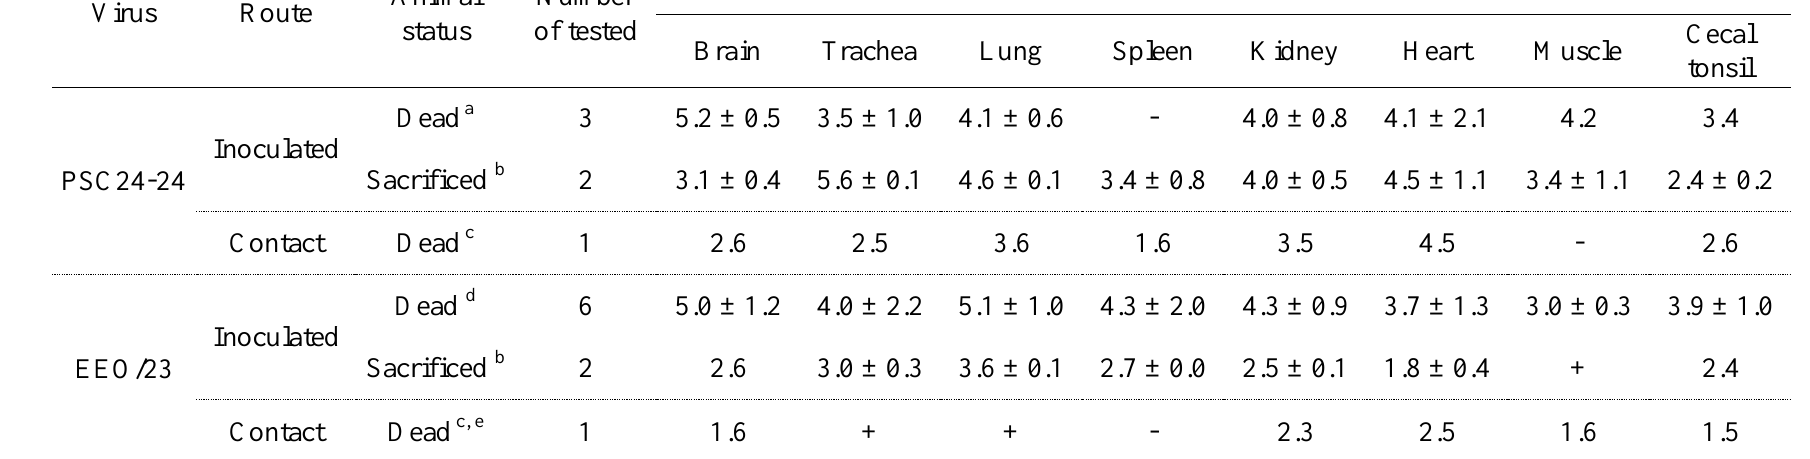
Table 4. Replication of the H5N1 AIVs in tissues of the ducks. 10 6.0 EID /0.1 ml of A/mandarin duck/Korea/PSC24-24/2010 (PSC24-24) and 50 A/Eurasian eagle owl/Korea/23/2010 (EEO/23) were inoculated intranasally to eight 2-week-old ducks, and 3 ducks were co-housed with the infected ducks as a contact group. Virus replication in tissues from sacrificed and dead birds in the inoculated groups were measured in CEF with 10% tissue homogenates. Virus titer is the average of calculable positive samples. The detection limit of the CEF cell culture was set to 10 0.6 TCID /0.1 50